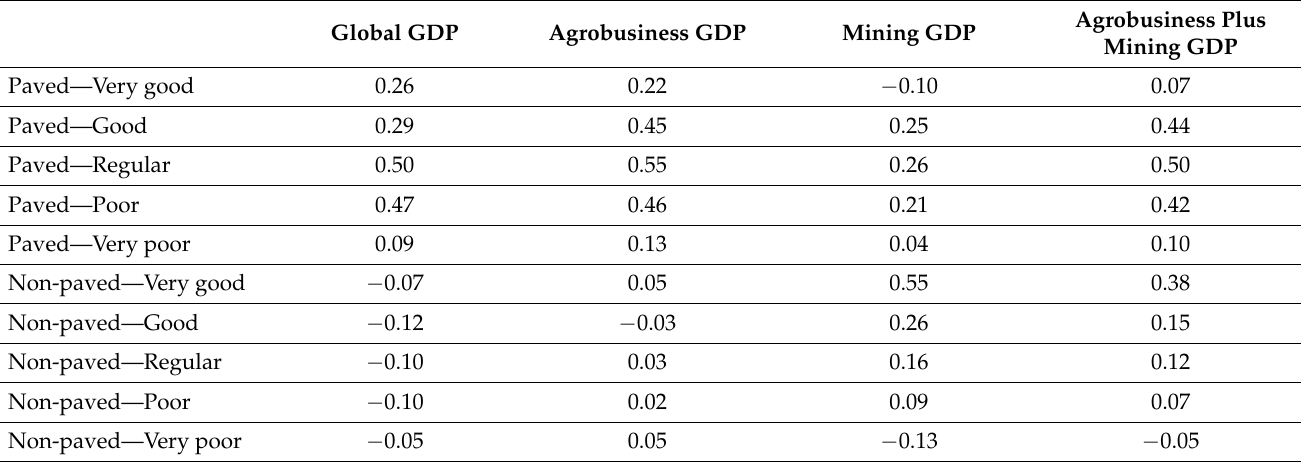
Table 8. R value upon correlating global and sector GDP, and length of tertiary road network in different conditions. Global GDP Agrobusiness GDP Mining GDP